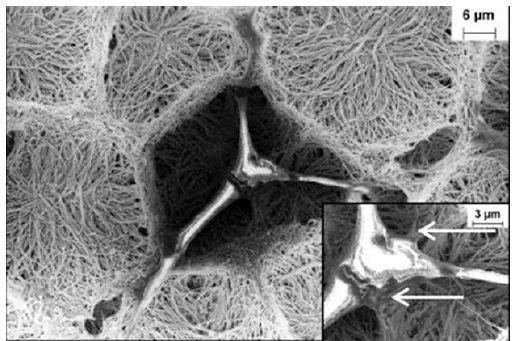
Figure 7. Scanning electron micrographs of L929 mouse fibroblasts growing on a multi-walled carbon nanotube (MWCNT)-based network [73]. Reproduced with copyright permission from the American Chemical Society, 2004.